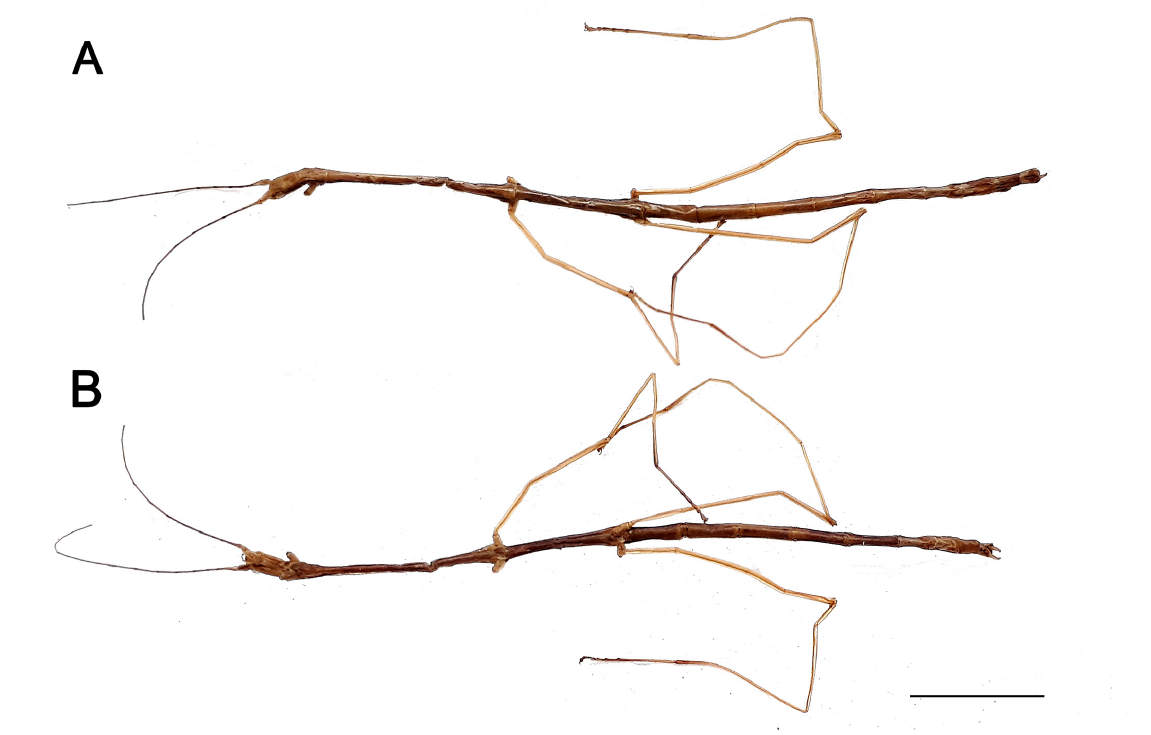
Fig. 29. Arumatia aramatia Ghirotto gen. et sp. nov., paratype, ♂ (MZUSP 1322). A . Dorsal view. B . Ventral view. Scale bar: 10